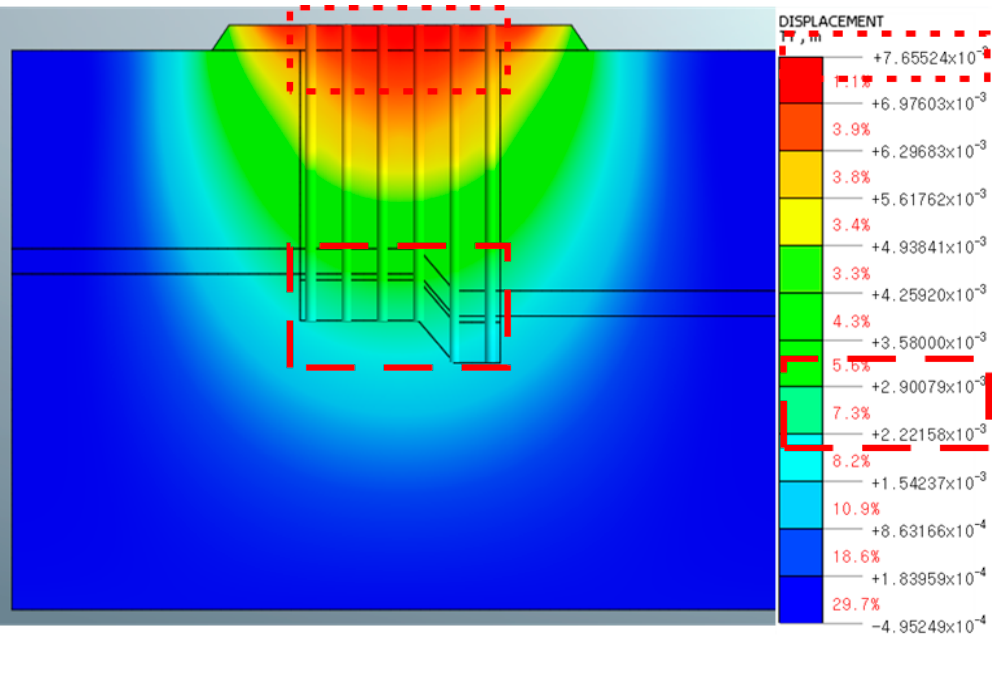
Figure 9. Numerical analysis result in the P2 direction, ( a ) Soft rock condition at 1.92 m and the integrated behavior of both the pile foundation and ground; ( b ) The soft rock insertion condition of 1.92 m and the on-site pull-out load test results are reflective of this.